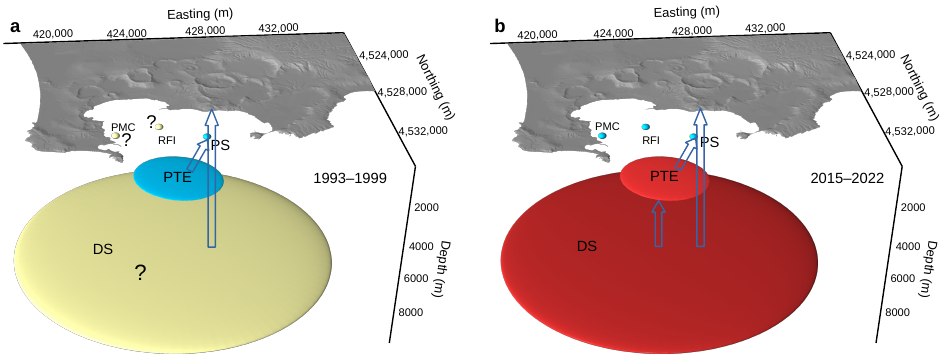
Figure 12. Cartoons of the dynamics of the PTE, DS, PS, RFI and PMC deformation sources in different periods. ( a ), 1993–1999; ( b ), 2015–2022. The time period in ( a ) is 1993–1999 instead of 1993–2000 (as from 1993-2000 SAR data) to exclude the 2000 mini-uplift (see Figure 2). Reddish colors indicate source inflation, cyan indicates deflation and yellow indicates lack of reliable detected activity, emphasized by question marks. Empty blue arrows schematize possible magmatic fluid transfers from the DS and